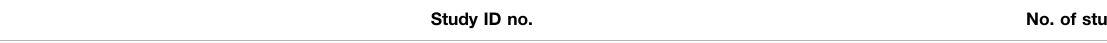
TABLE 11 | Studies relevance to RQs. RQ no. Study ID